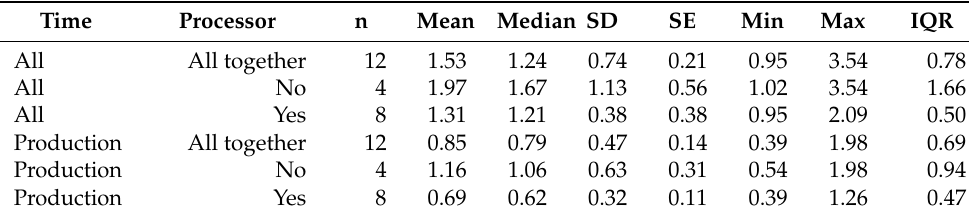
Table 6. Time consumption (man-hour m − 3 ): descriptive